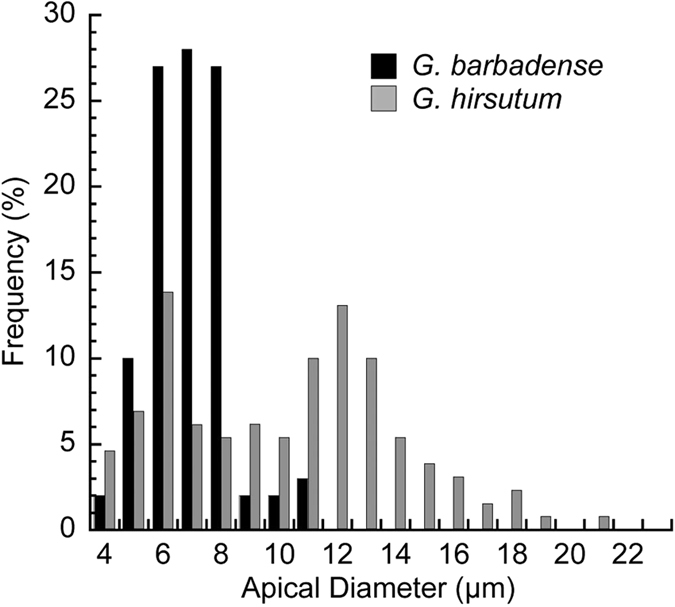
G. barbadense (Gb) fibers had only one narrow tip morphology at 5 DPA.The distribution of apical diameters (10 μm from the apex) is shown in 1 μm increments (n = 60). Data for Gh hemisphere and tapered tips from Fig. 2C were combined and overlaid for comparison.